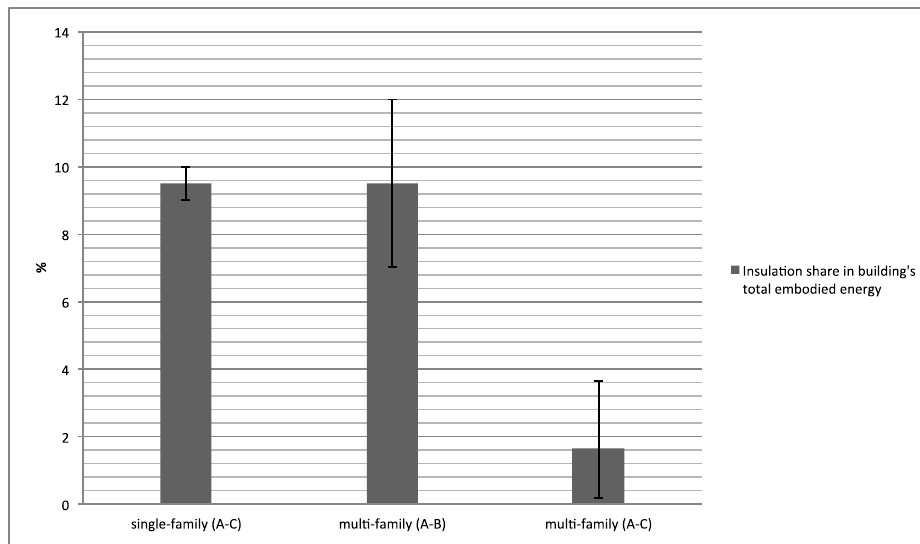
Figure 4. Share of the insulation in the building life cycle energy use considering single-family and multi-family residential buildings. The error bars are related to variation in contribution percentages. Acronyms A, B and C refer to the building’s life cycle stages according to EN 15978, namely products manufacturing stage, use stage and end-of-life stage, respectively. The first column shows results range extrapolated from [27,29]. The second column shows the contribution range found by [12] considering a standard and a well-insulated building, excluding the building end-of-life phase (C). The third column indicates contribution extrapolated from [31] considering an existing building with no refurbishment, with medium refurbishment and with advanced refurbishment.